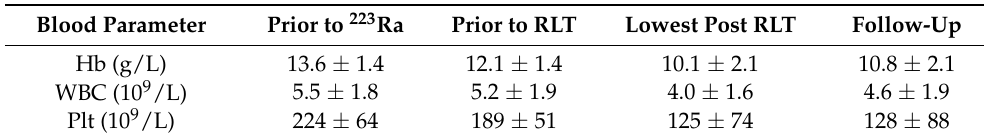
Table 4. Median hemoglobin (Hb), white blood cell counts (WBC) and platelets (Plt) with standard deviation prior to 223 Radium-dichloride ( 223 Ra), at baseline, upon maximum deterioration and in follow-up. Blood